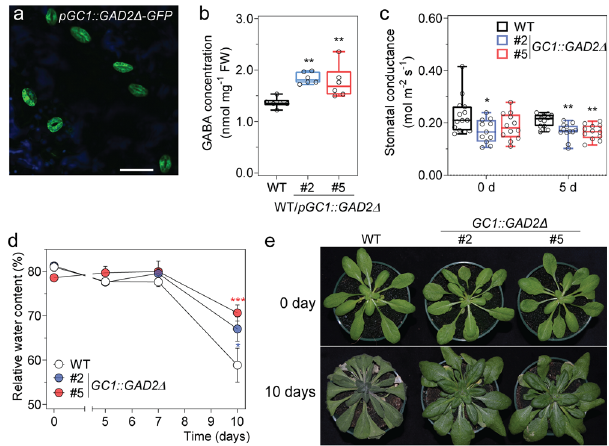
Fig. 5 Guard cell overexpression of GAD2 Δ decreases plant water loss and increases drought survival. a Representative confocal images of